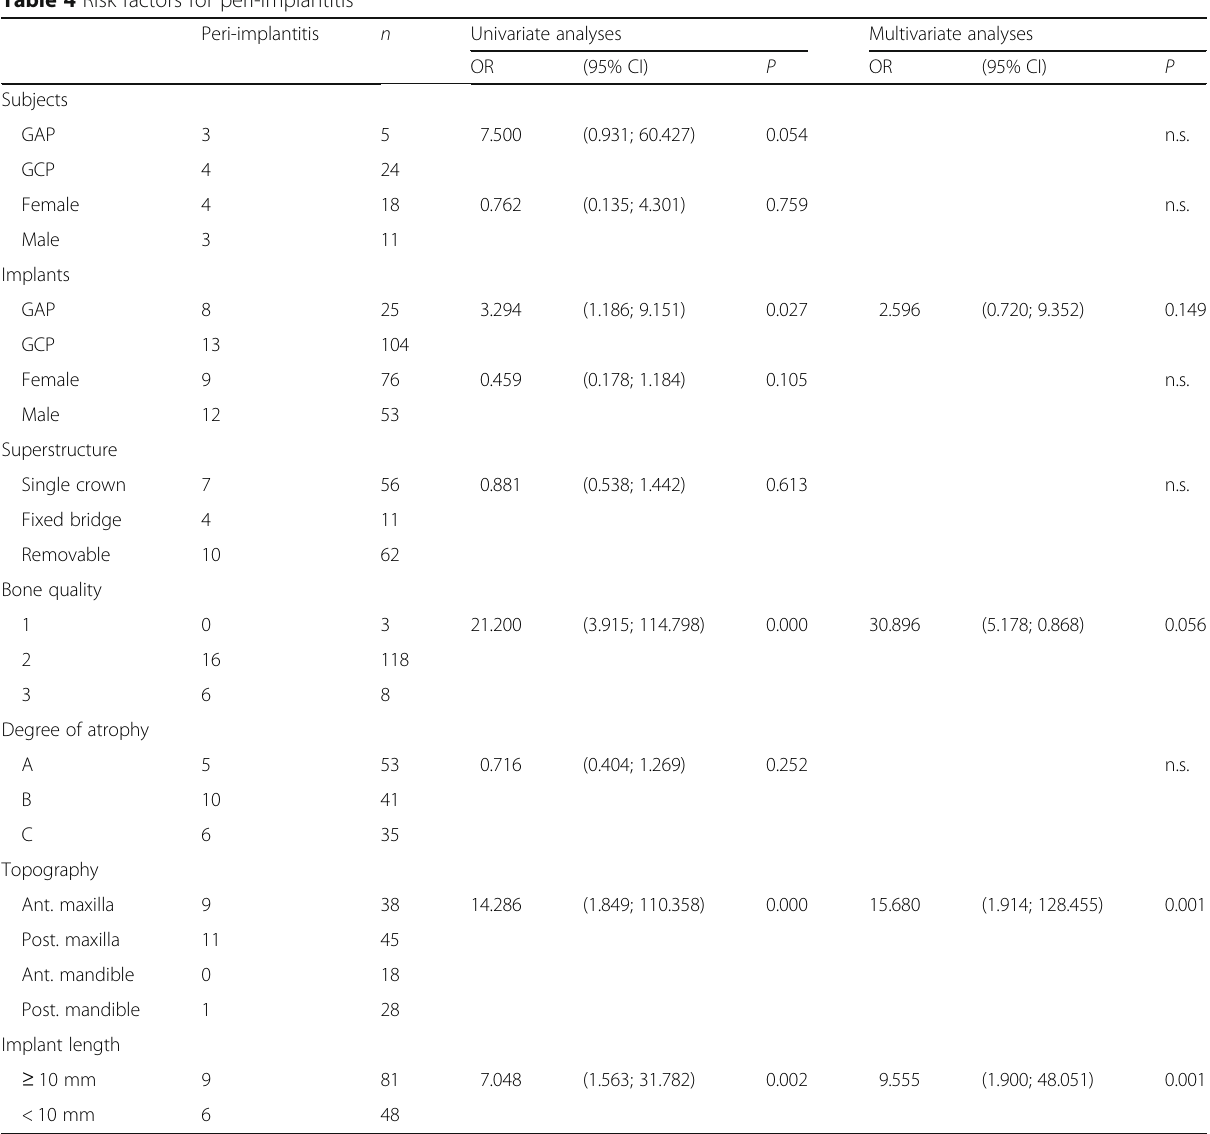
Table 4 Risk factors for peri-implantitis Peri-implantitis n Univariate analyses Multivariate